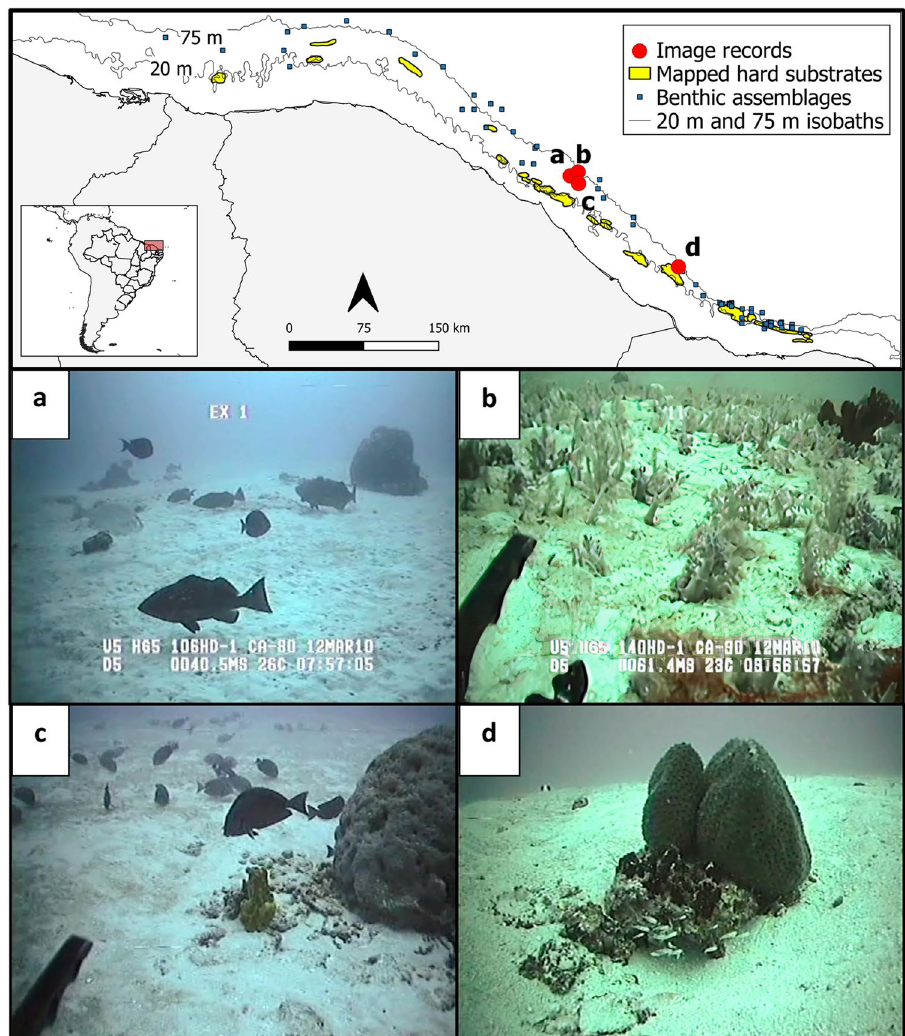
Figure 4. Putative rocky substrates on the outer continental shelf off the Brazilian semi-arid coast. Massive sponges and reef-associated fishes (families Acanthuridae, Lutjanidae, and Epinephelidae) observed by Remotely Operated Underwater Vehicle (ROV) suggesting the occurrence of widespread hard substrates at mesophotic depths. ( a ) Massive sponges ( Agelas dispar ) and reef fishes ( Lutjanus jocu , Mycteroperca sp., Epinephelus